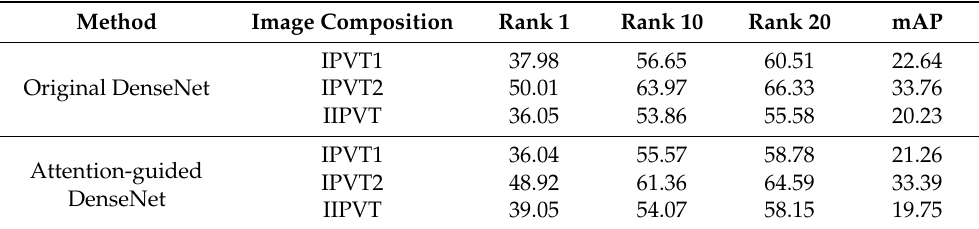
Table 7. Comparisons of ReID accuracies according to various input image compositions with SYSU-MM01 (unit: